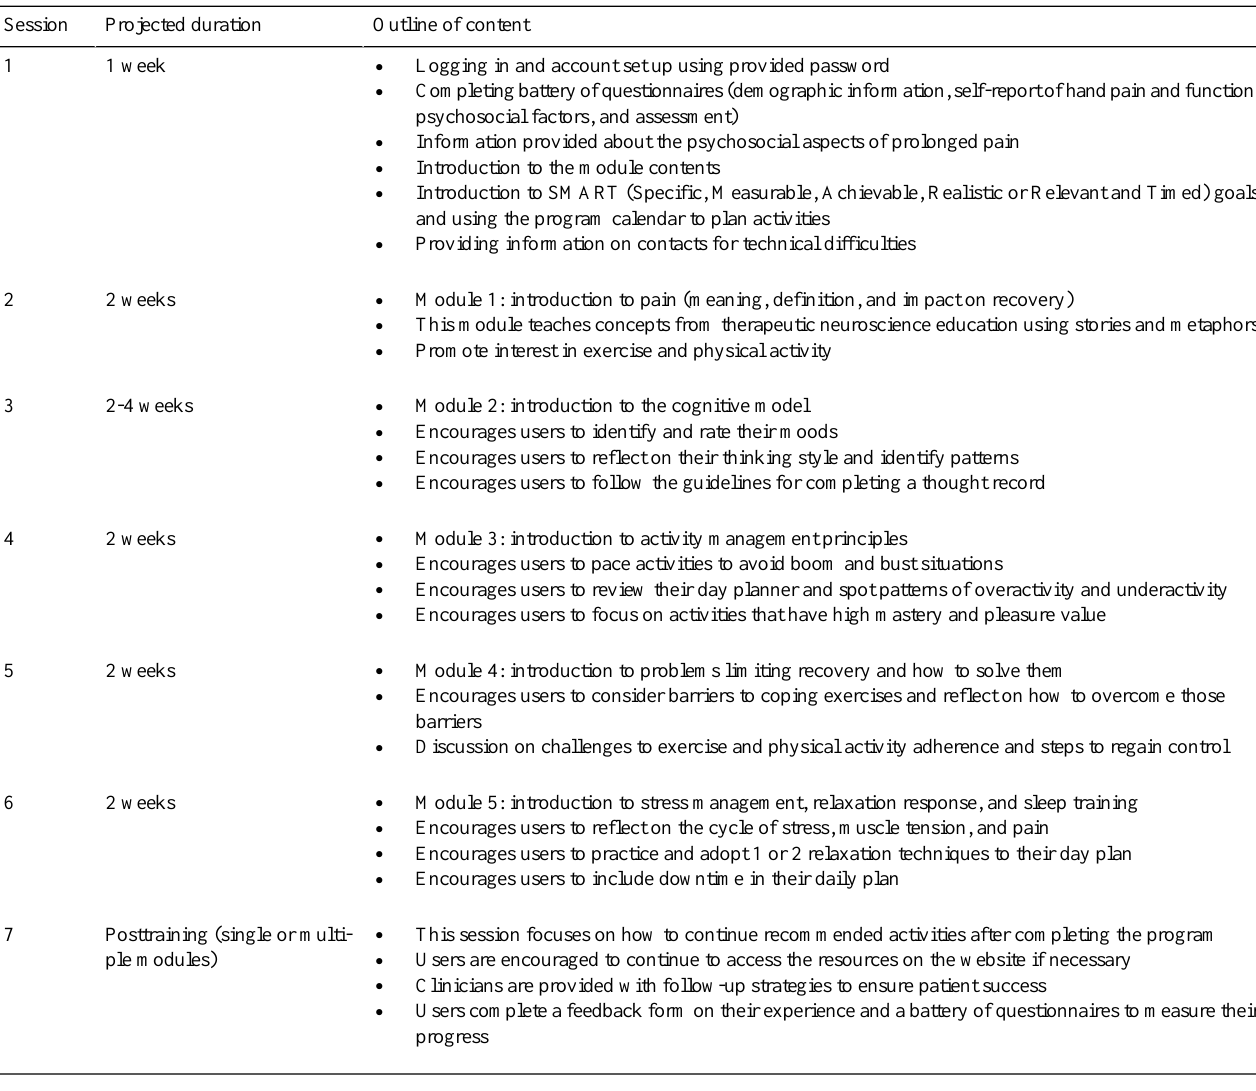
Table 1. Outline of hand therapy online coping skills session contents.